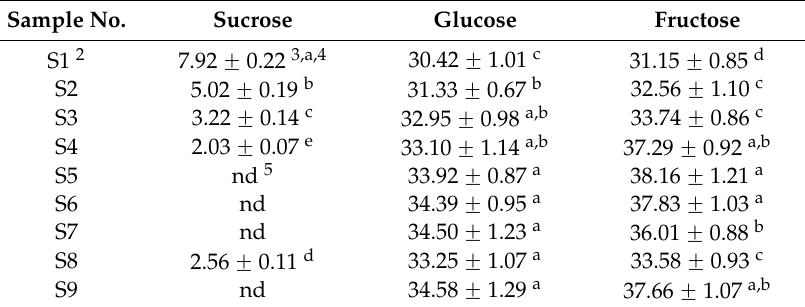
Table 4. The analysis results of saccharides in the samples (%, DW 1 , n = 3). Sample